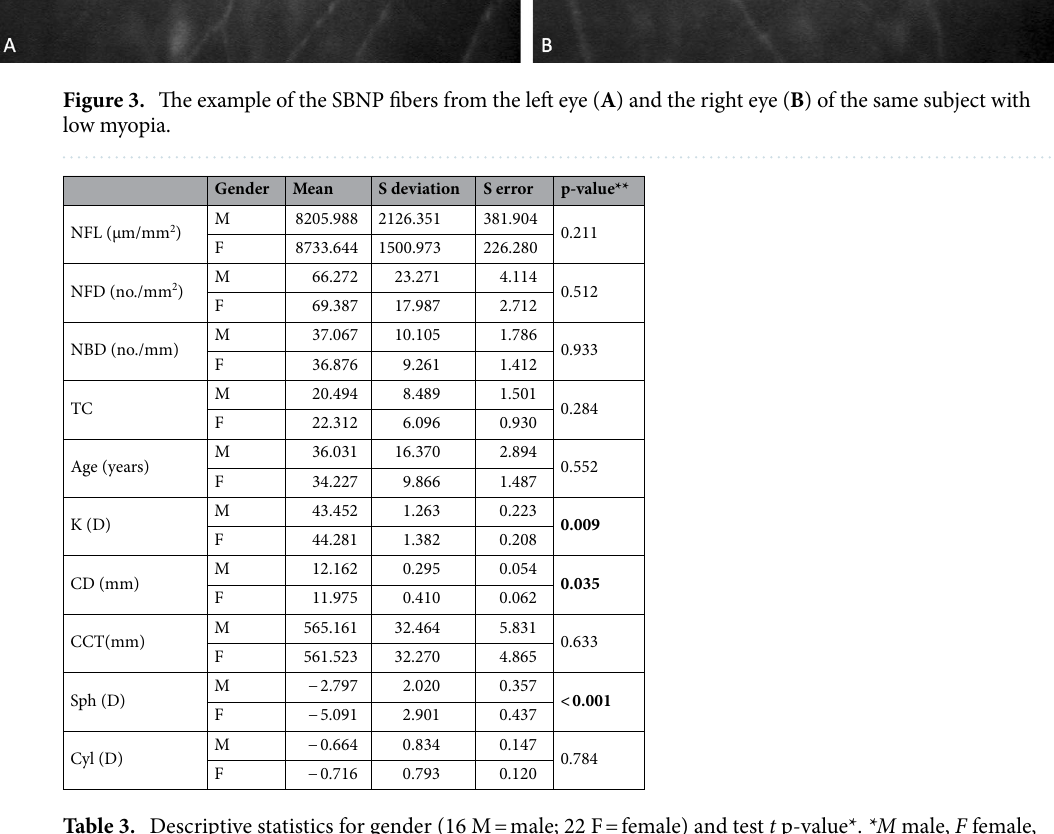
Table 3. Descriptive statistics for gender (16 M = male; 22 F = female) and test t p-value*. *M male, F female, NFL nerve fiber length (µm/mm 2 ), NFD nerve fiber density (no./mm 2 ), NBD nerve beadings density